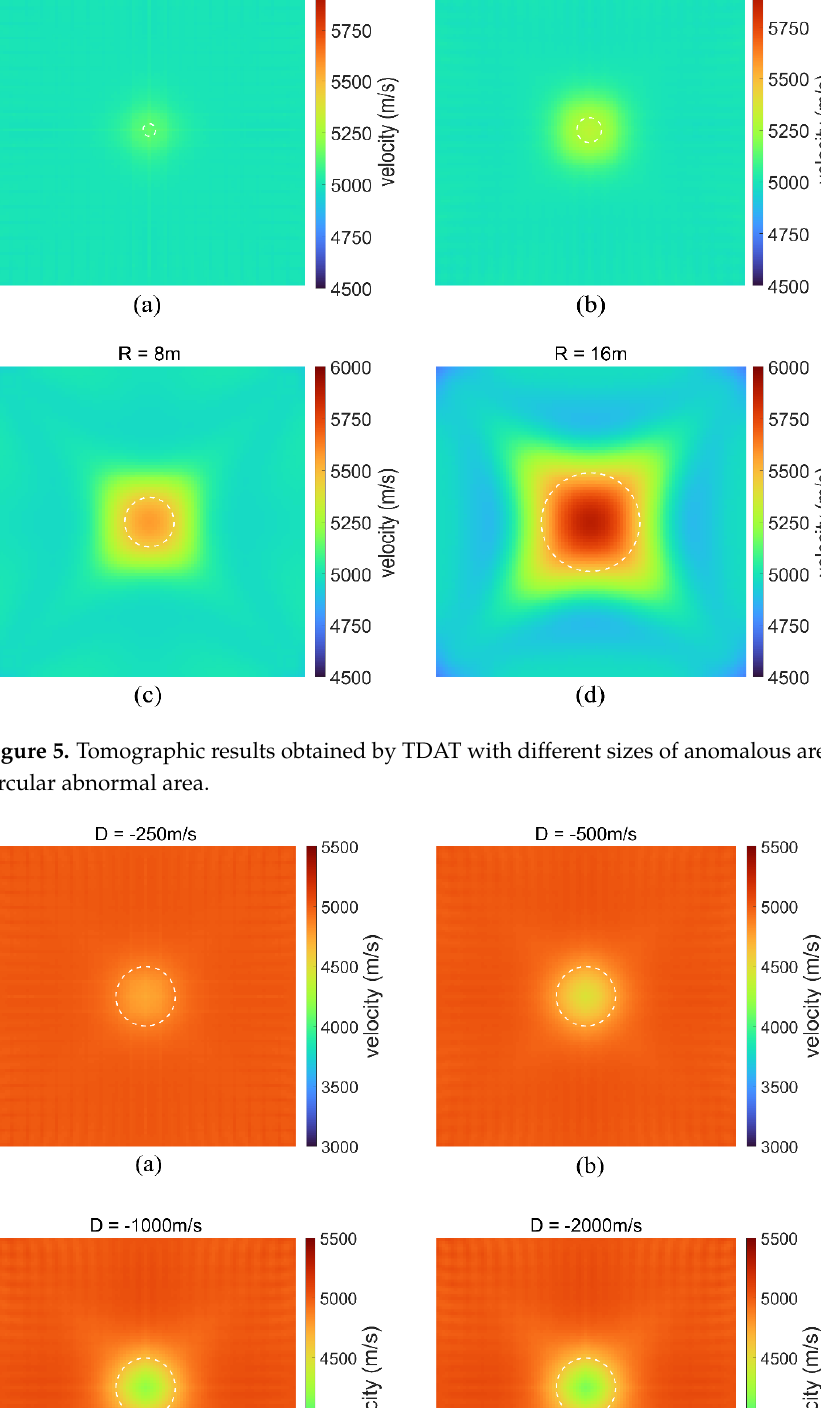
Figure 7. Tomographic results obtained by TDAT with different high-velocity anomalies. D: velocity difference between background and anomalous area.